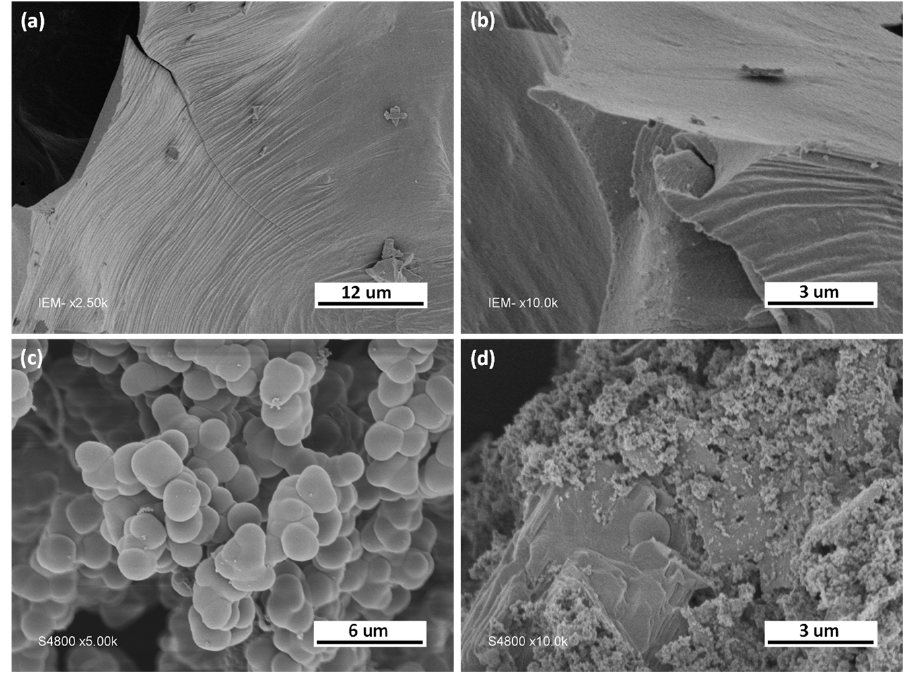
Figure 2. SEM images: ( a , b ) BCN − 1; ( c , d ) BCN − 11.